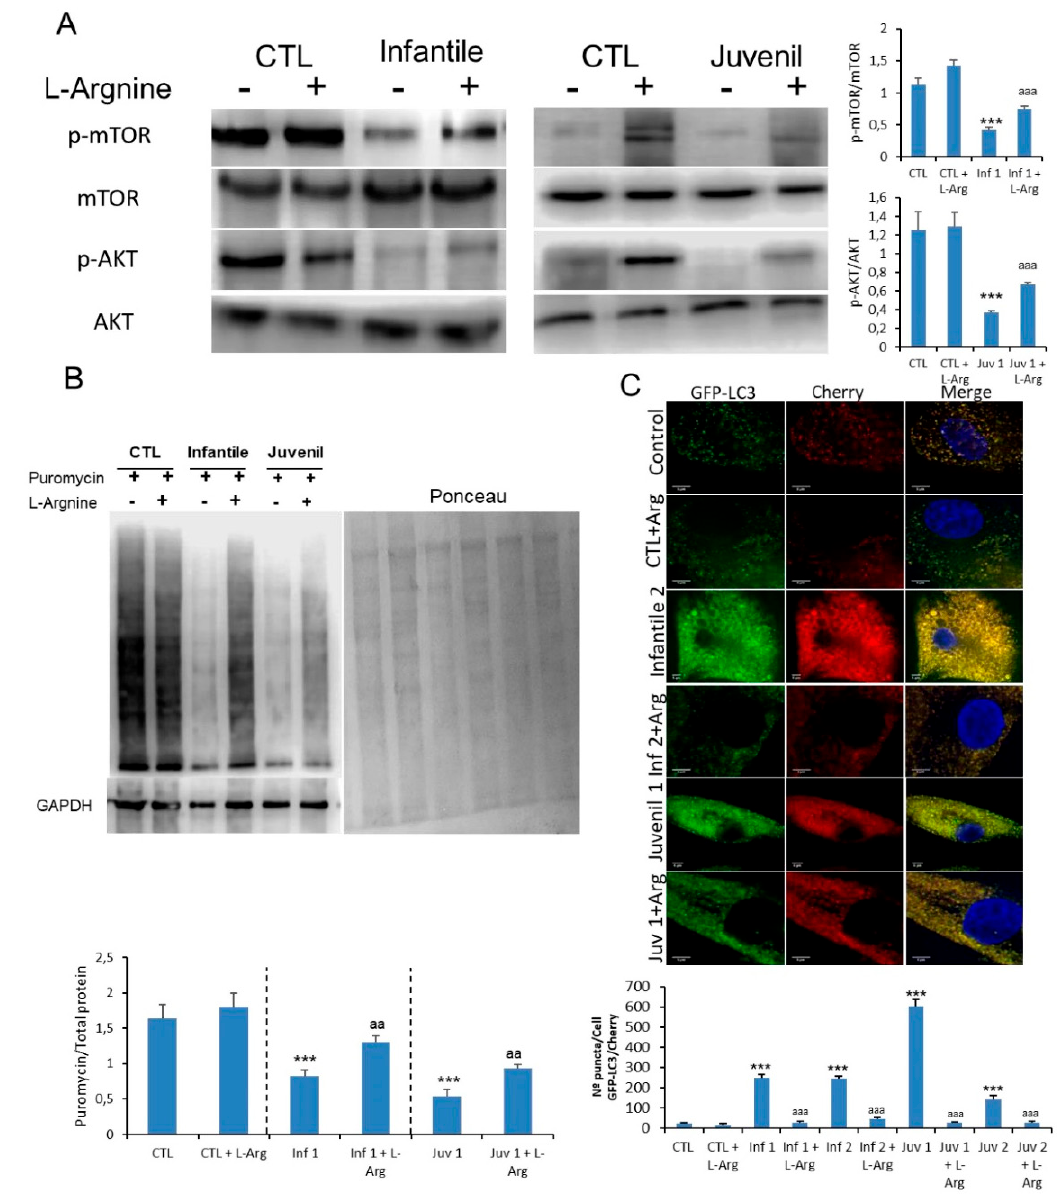
Figure 6. ( A ). Expression of mTOR and AKT determined in control and representative Tay–Sachs fibroblasts after L ‐ argi ‐ nine treatment. ( B ). Protein synthesis was quantified in extracts of control and Tay–Sachs fibroblasts treated with L ‐ argi ‐ nine using puromycin labeling followed by immunoblotting. ( C ). Representative image of Tay–Sachs treated fibroblasts after transfection of the mCherry ‐ GFP ‐ LC3 plasmid and quantification of autophagic puncta. For control cells, the data are the mean ± SD for experiments conducted on two different control cell lines. GAPDH was used as a loading control. Data represent the mean ± SD of three separate experiments. *** p < 0.001 between control and Tay–Sachs fibroblasts; aa p < 0.01; aaa p < 0.001 between non ‐ treated and treated cells.